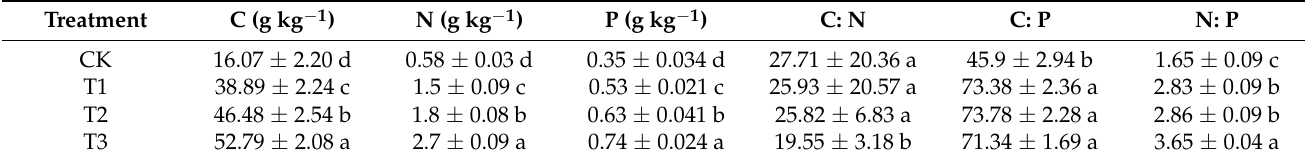
Figure 2. Changes of C, N, and P contents in moss crusts underlying soil ( A – C ) and moss crusts ( D – F ) with different levels of biochar addition. The C, N, and P contents are total forms, CK:0 t ha − 1 ; T1: 3.185 t ha − 1 ; T2: 6.37 t ha − 1 ; T3: 12.74 t ha − 1 ). Different capital letters indicate a significant difference among five sampling months with the same treatment; different lowercase letters indicate a significant difference among four biochar treatments in the same sampling period. Vertical bars show the standard error (SE) ( n = 3). Table 2. The C, N, and P characteristics of the moss crusts along biochar addition gradients, the data is the average value of stoichiometric characteristic values from June to October under the same treatment (mean ±